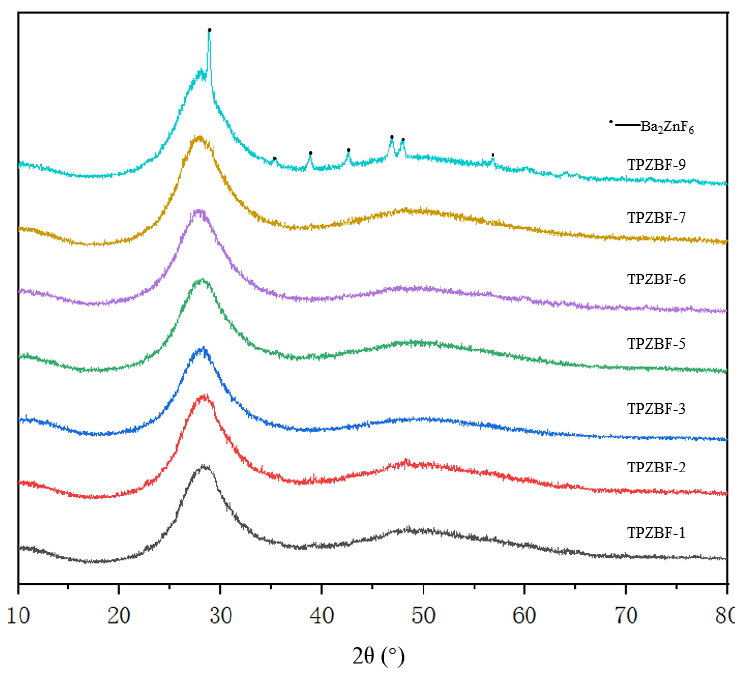
Figure 3. XRD diagram of TPZBF series glass.